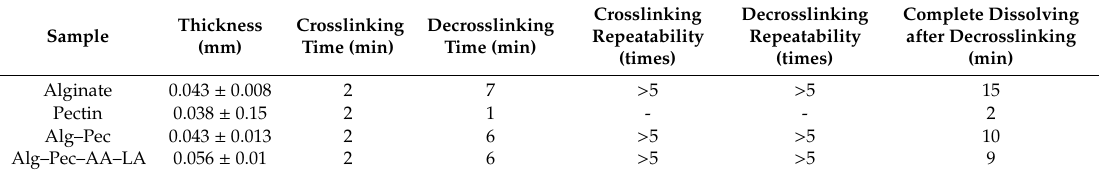
Table 1. Dissolvability and reusability analysis of pectin, alginate, and their biocomposite films.